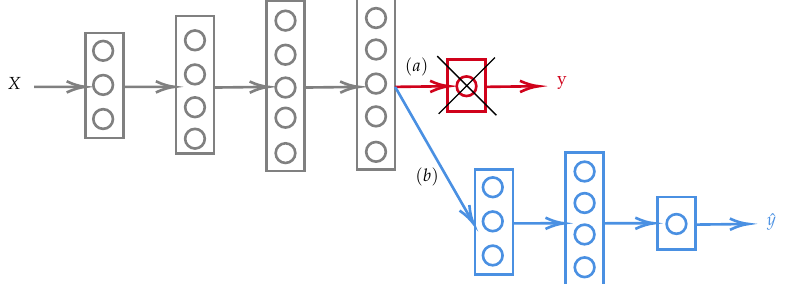
Figure 2. Illustration of the transfer learning process. Transfer learning involves adapting a pre- trained CNN model to suit the requirements of a new problem. In this case, consider the original model ( a ) that has been trained to recognize objects from a dataset such as ImageNet. If X is the input image and y is the predicted class of that model, then by removing some layers, including the last layer from the original model, we can obtain an architecturally different model ( b ) through adding more layers for learning new information from a different dataset to make new predictions ˆ y